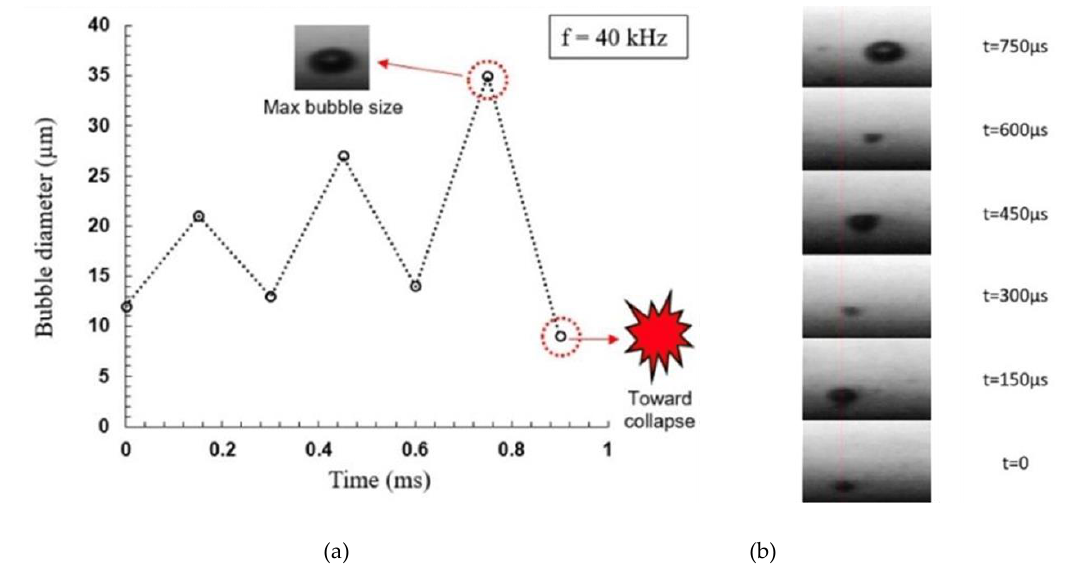
Figure 5. Size variation of a single bubble in an acoustic field: (a) Schematic representation of the single bubble lifetime at an applied frequency of 40 kHz; (b) Captured images of rectified diffusion of the single bubble